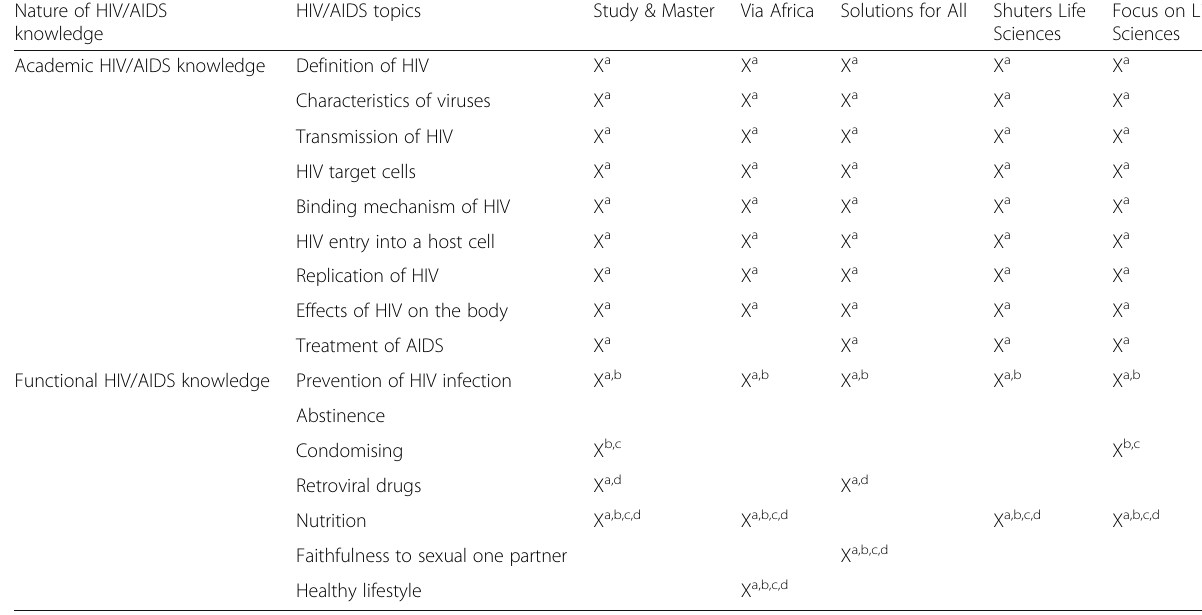
Table 2 Curriculum ideology that foreground HIV/AIDS knowledge presented in the Life Sciences textbooks Nature of HIV/AIDS